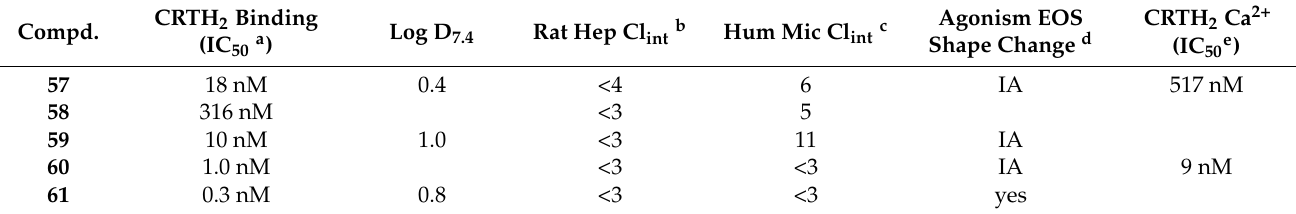
Table 3. Preliminary SAR of compounds 57 – 61 (values were obtained from [75]).